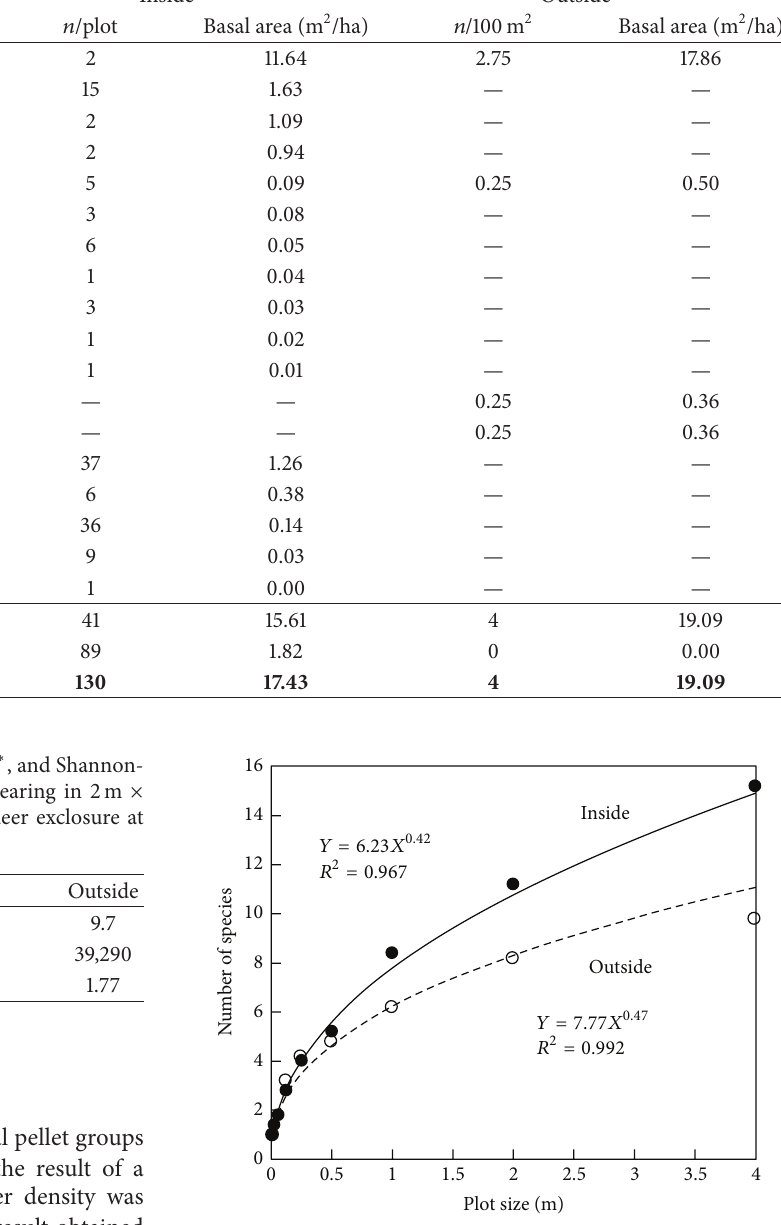
Figure 2: Relations of plot size and mean number of species present on each of the five 2 m × 2 m plots inside and outside the deer exclosure in Okutama, western Tokyo,